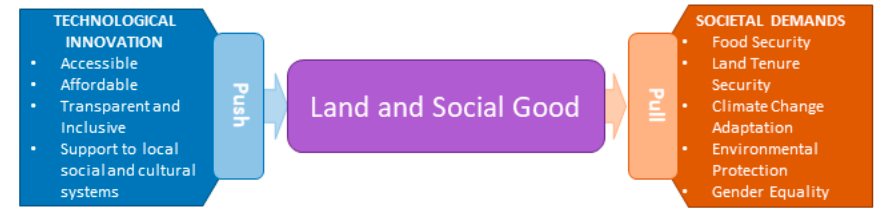
Figure 1. The aspects of land, innovation, and social good.